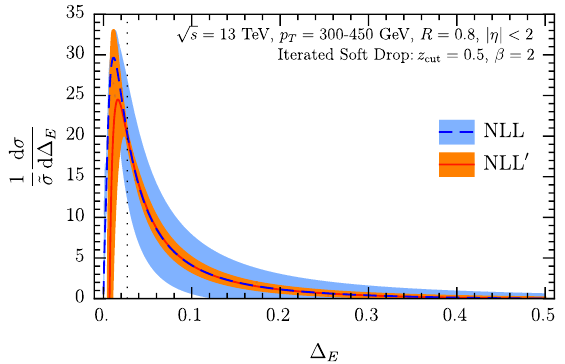
Figure 7 . Comparison of the QCD scale uncertainties at NLL and NLL 0 , for the lower left panel of figure